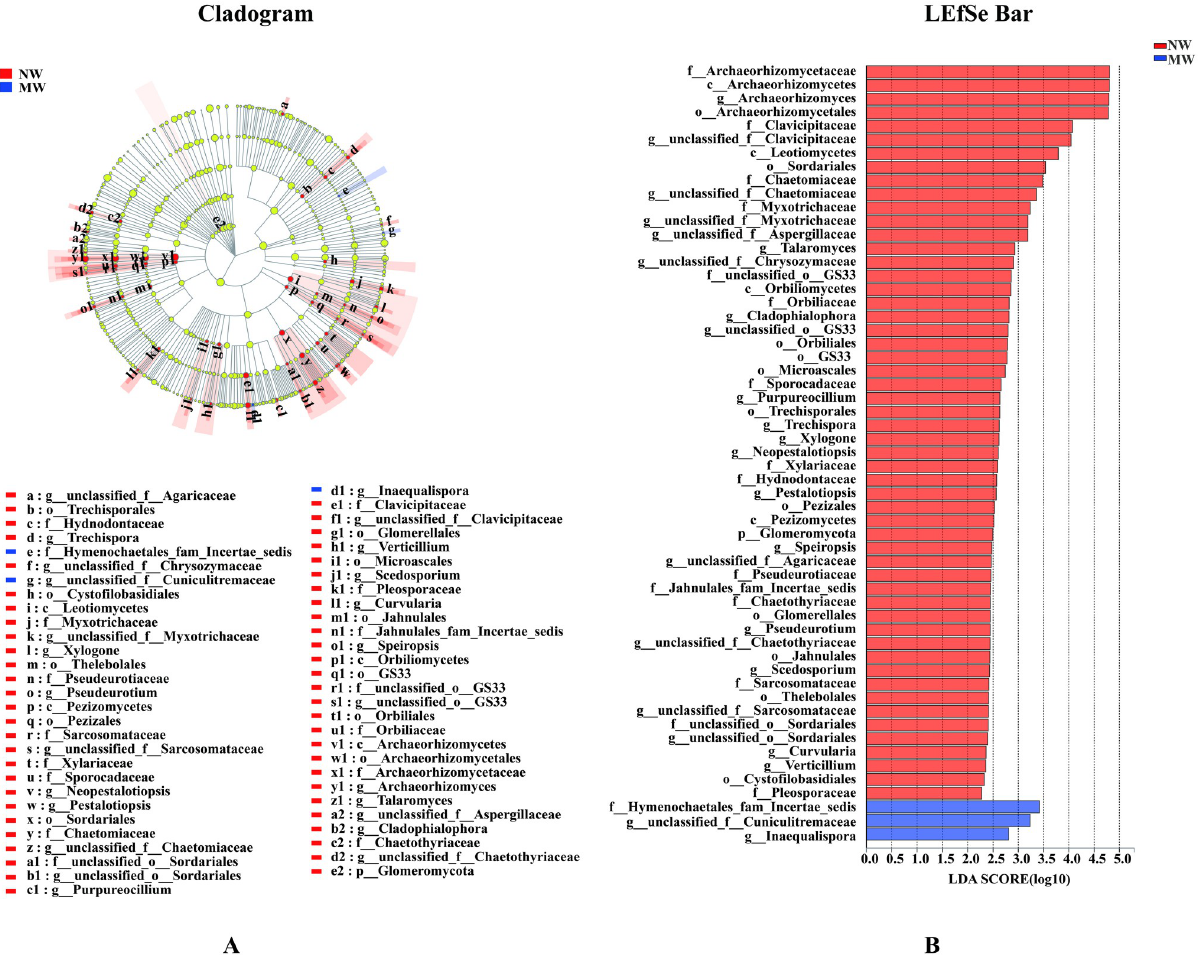
Fig 6. Cladogram showing the phylogenetic distribution of the fungal lineages associated with soil from two treatments (A). Indicator fungi with LDA scores of 2 or greater in fungal communities associated with soil from the two treatments (B). Different colour regions represent different constituents (Red, NW; Blue, MW). Circles indicate phylogenetic level from phylum to genus. The diameter of each circle is proportional to the abundance of the group. Different prefixes indicate different levels (p: phylum; c: class; o: Order; f: Family; g: Genus). Note . NW: no weeding in the star anise plantation, and MW: mechanical weeding in the star anise